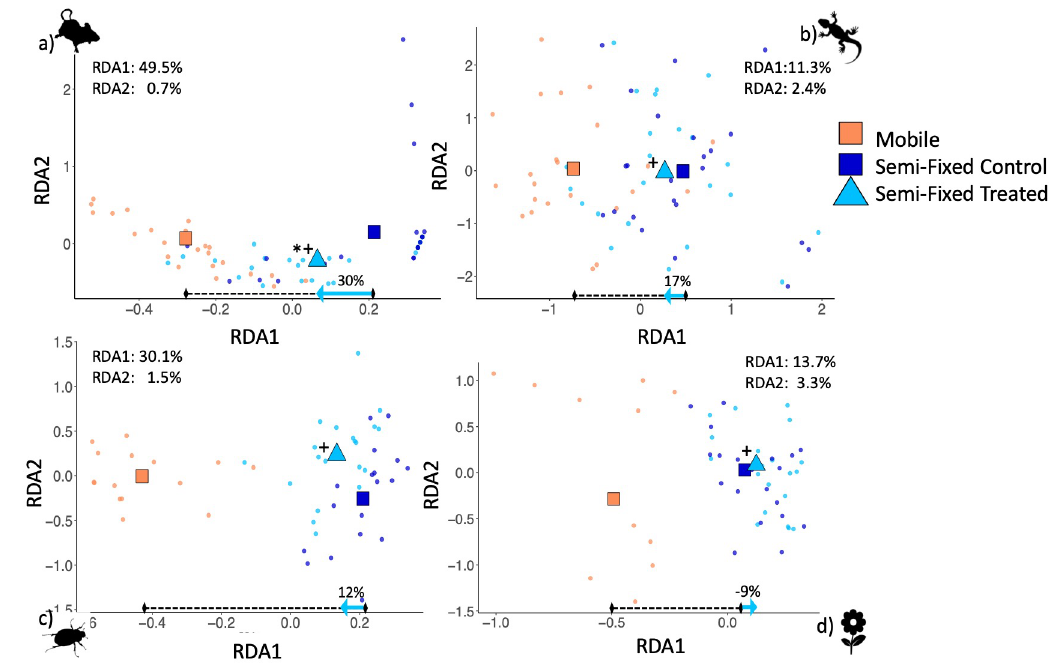
Figure 5. Redundancy analysis for ( a ) rodents, ( b ) reptiles, ( c ) beetles and ( d ) annual plants in treated semi-fixed dunes (pale blue triangle) compared to un-treated semi-fixed (control) dunes (dark blue square) and Mobile dunes (orange square) which are the treatment reference. Distance bars along the 1st RDA axis show the treatment e ff ect (blue arrow) as a percentage of total distance between control and reference (black dashed). Significant di ff erences were tested using pairwise Permanova. * and + represent p < 0.05 for treated dunes compared to control and reference dunes,